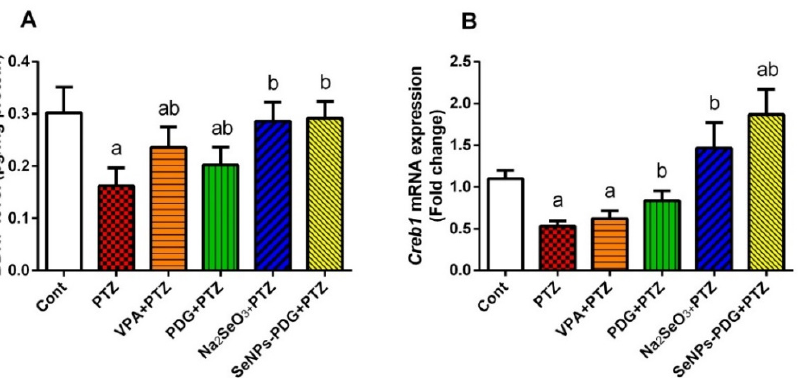
Figure 5. Effects of orally administered prodigiosin (PDG), sodium selenite (Na 2 SeO 3 ), and green biosynthesized SeNPs with PDG (SeNPs-PDG) on ( A ) BDNF and ( B ) Creb-1 mRNA expression levels in hippocampal tissue following pentylenetetrazole (PTZ)-induced epileptic seizures. a and b denote significant differences ( p < 0.05) relative to the untreated control and PTZ-injected groups, respectively. All results are presented as the mean ± standard deviation (SD).